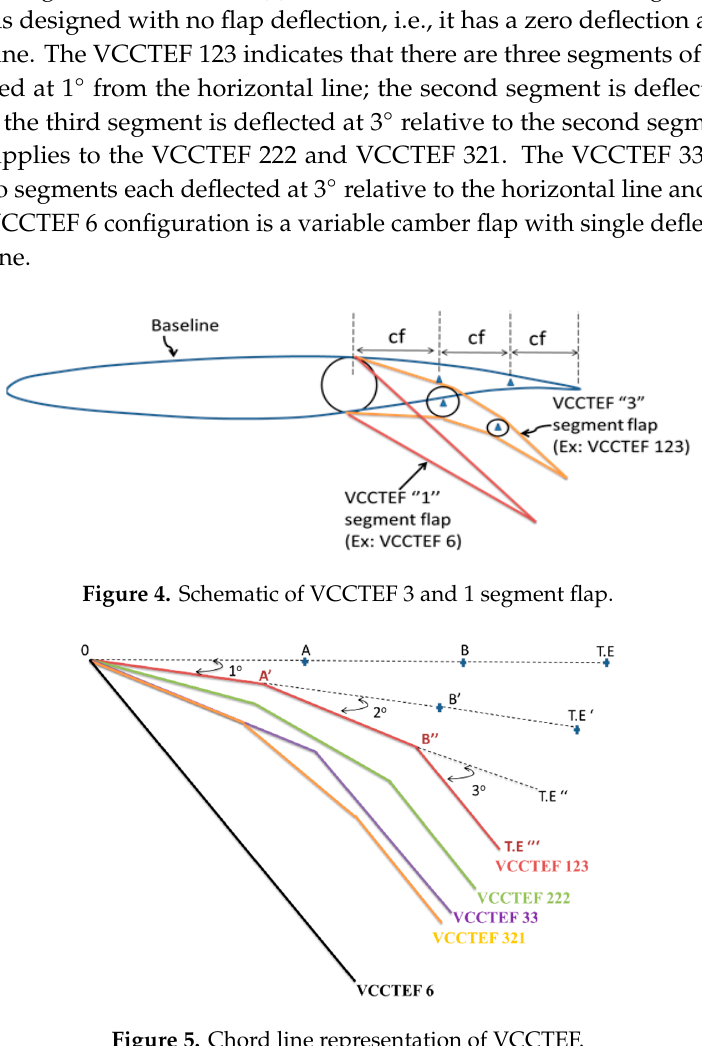
Figure 5. Chord line representation of VCCTEF.